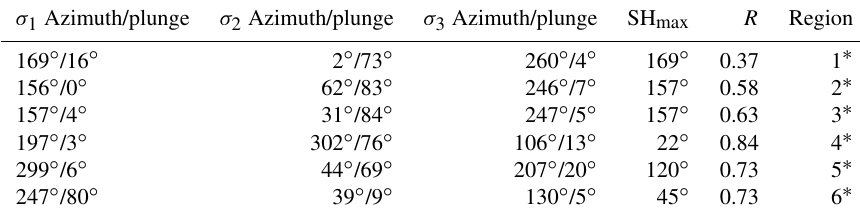
M m is the magnitude of the mainshock; M a is the magnitude of the largest aftershock; D is the difference in magnitudes of the mainshock and its largest aftershock; p , c , and k are the coefficients of Omori’s law. Table 4. Stress inversion results. σ 1 Azimuth/plunge σ 2 Azimuth/plunge